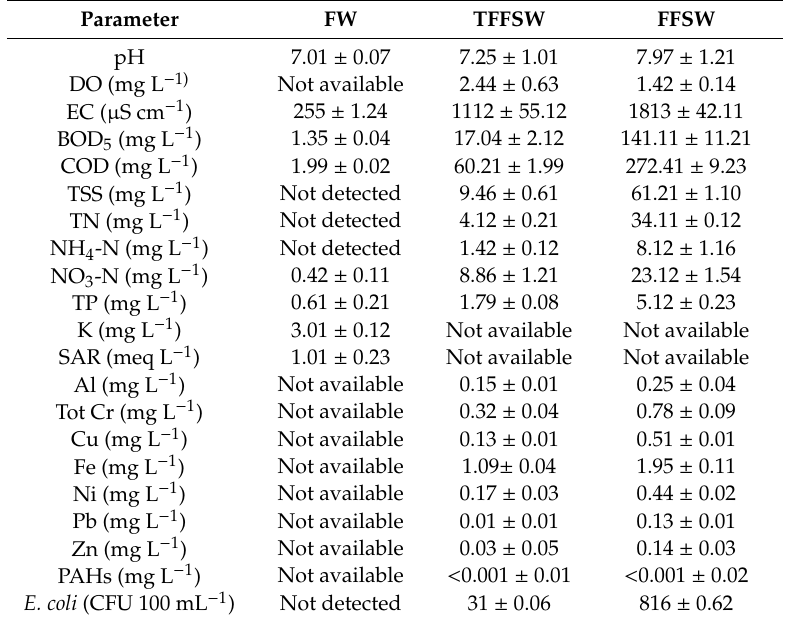
Table 5. Chemical and microbiological composition of freshwater (FW), treated FFSW (TFFSW) and FFSW that were applied in the irrigation of ornamental pepper and rosemary